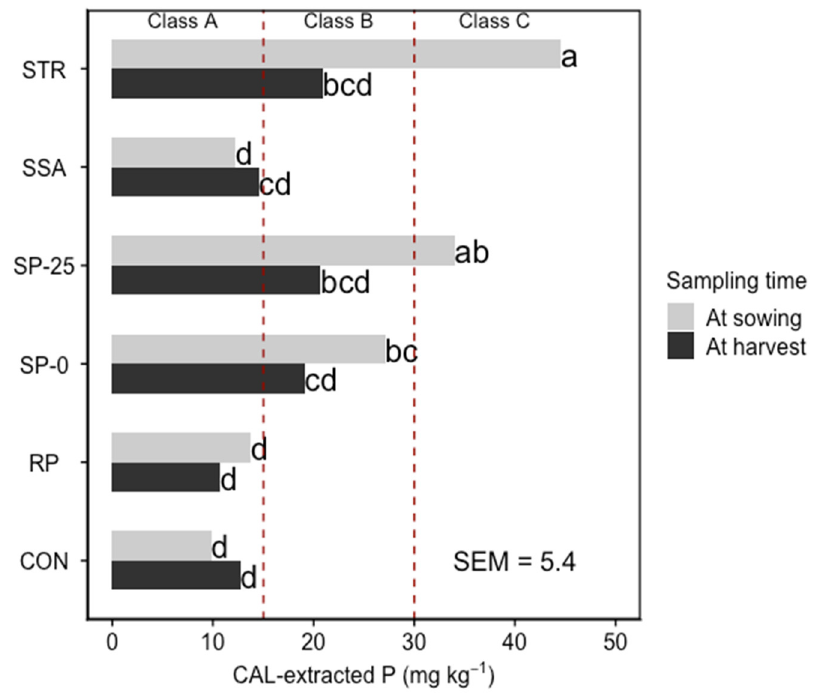
Figure 2. Mean Calcium-Acetate-Lactate extractable phosphorus (CAL-P) (mg kg − 1 ) at sowing and at harvest. Class A–C are soil plant-available P classifications for fertilization recommendation in Germany (Class A: strong need for fertilizing to Class C; Class B: need for fertilizing to Class C; Class C: only fertilize the P removal by harvest) [24]. The same letters indicate no significant differences between the treatment ( n = 4, Tukey’s HSD test ( α = 0.05)). SEM = standard error of the mean. For fertilizer abbreviations, see Table 1.